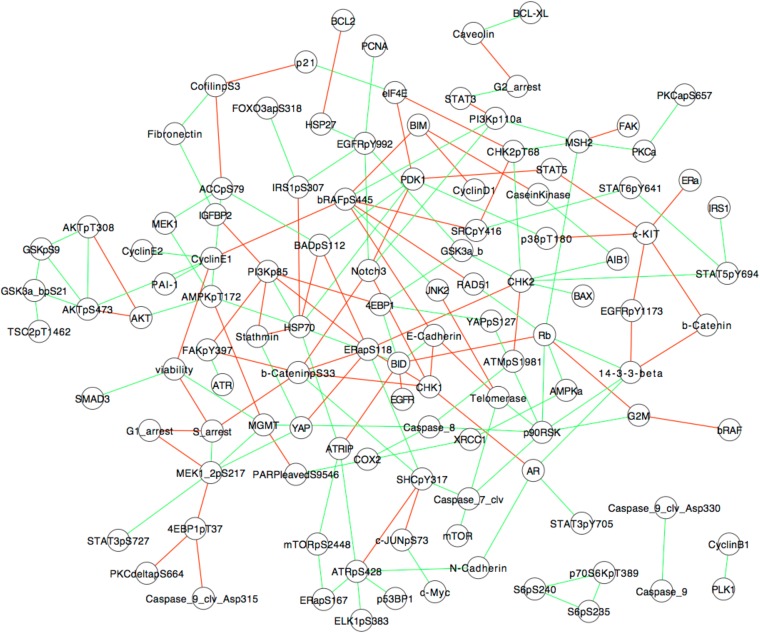
Association models of the response map from partial correlations.A correlation-based network model of signaling is inferred using the SkMel-133 perturbation response data and the graphical Gaussian model (GGM) network inference method. GGM uses the first-order partial correlation coefficients as a measure of direct associations between two nodes, for which the effects of other nodes are eliminated. The advantage of partial correlations over the conventional pairwise correlations is its ability to distinguish direct interactions from indirect ones. Partial coefficients are calculated by inverting the correlation matrix. Here, we computed the partial correlations using the shrinkage estimation method, a form of regularized estimator of the covariance matrix and its inverse (Schafer and Strimmer, 2005). Shrinkage method is particularly useful for inferring models when number of variables is higher than number of constraints (n > p). See (Schafer and Strimmer, 2005) for algorithmic details and formulation of partial correlation calculation. The network model covers the interactions between 138 proteomic species and five phenotypic measurements (i.e., cell viability and cell cycle progression nodes). The models involve the interactions with statistically significant (False Discovery Rate (FDR) -adjusted p-value < 0.01, H0: pcor = 0 based on a null-distribution estimated from the data, see Schafer and Strimmer, 2005, for details) association strengths (green: positive, red: negative associations). The resulting models capture some of the well-characterized and potentially interesting interactions such as those between AKT, GSK3, and TSC2. Cell viability node is directly linked to proteomic nodes SMAD3, Cyclin E1, MGMT. G1-arrest node is directly linked to MEK phosphorylation node, while S-arrest is associated with beta-catenin phosphorylation node. G2-arrest is linked to STAT3 and caveolin total levels, and G2M transition is linked to BRAF, RB, and p90S6K total level nodes. The models provide an approximate picture of pairwise interactions in SkMel-133 cells, are not executable, do not capture the high-order couplings within the cellular system, and hence, we conclude that they do not have the required power for predicting system response to untested perturbations.